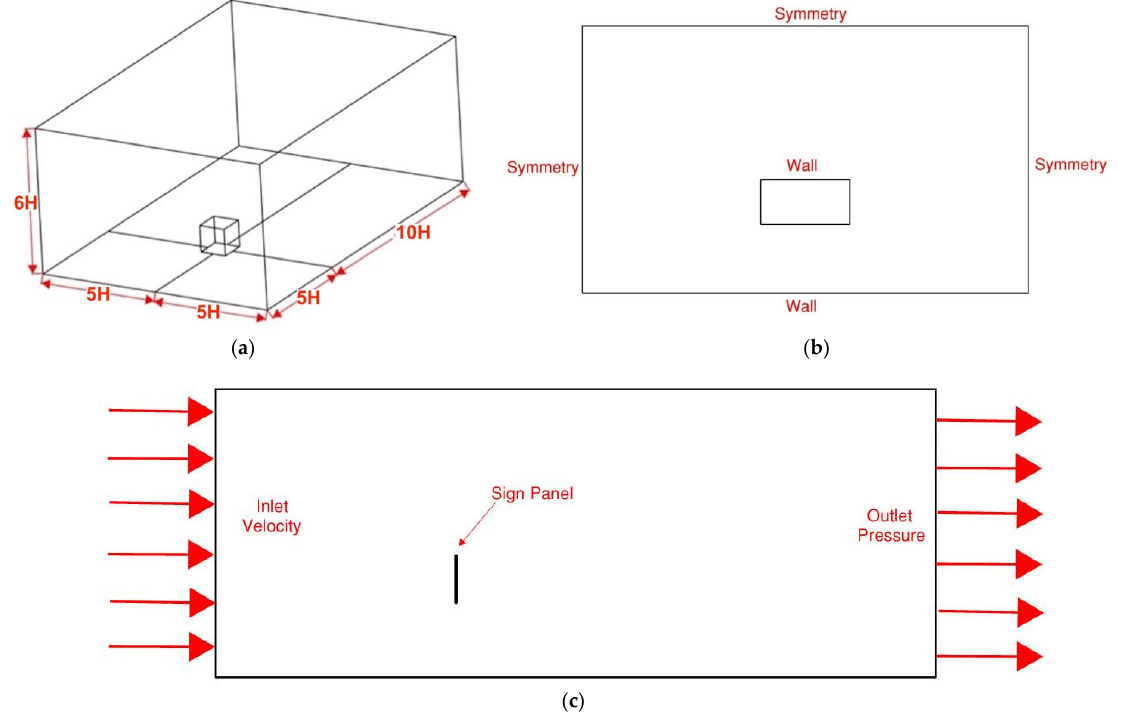
Figure 1. Computational domain: ( a ) domain dimensions for an object with height H, ( b ) wall and symmetric boundary conditions, and ( c ) inlet and outlet boundary conditions.